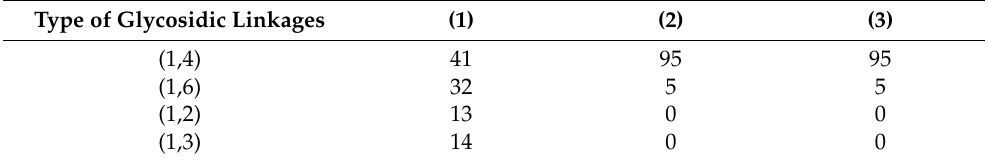
Table 1. Indicative values of the glycosidic bond distribution (in %), respectively, in (1) corn dextrin, (2) standard maltodextrin, and (3) starch, according to Lefranc-Millot [10]. Reproduced with permission from C. Lefranc-Millot, NUTRIOSE® 06: a useful soluble dietary fibre for added nutritional value; published by John Wiley and Sons,